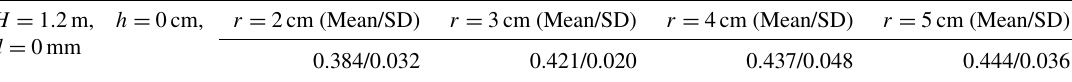
Table 1. The COR of block collisions with the plate.